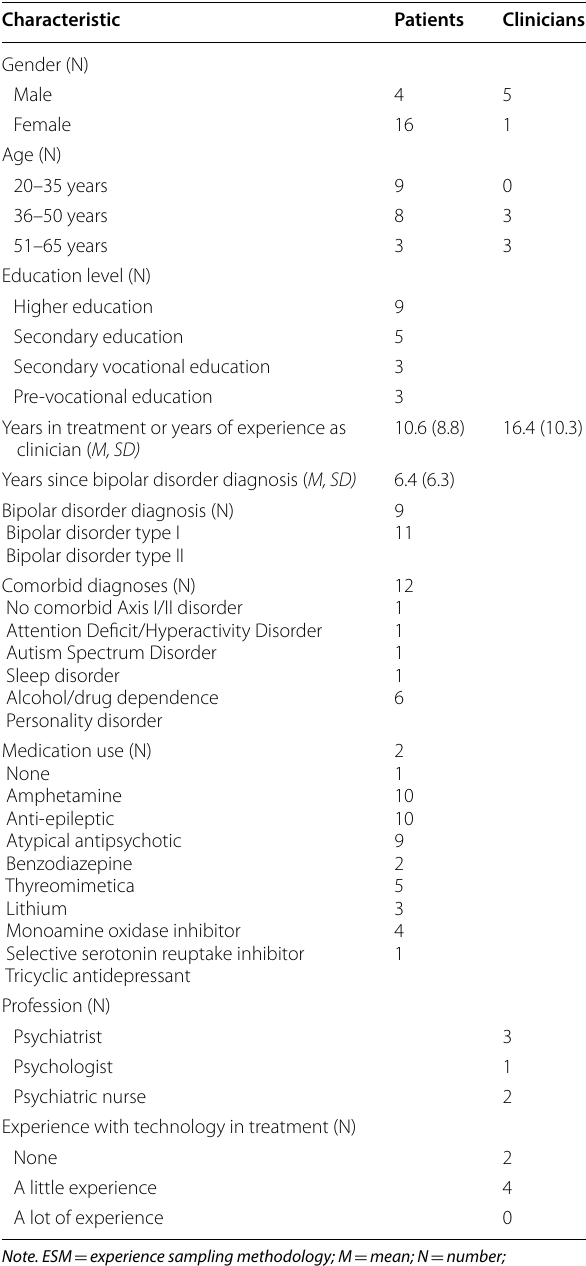
Table 1 Baseline demographic and clinical characteristics of patients (N 20) and clinicians (N =